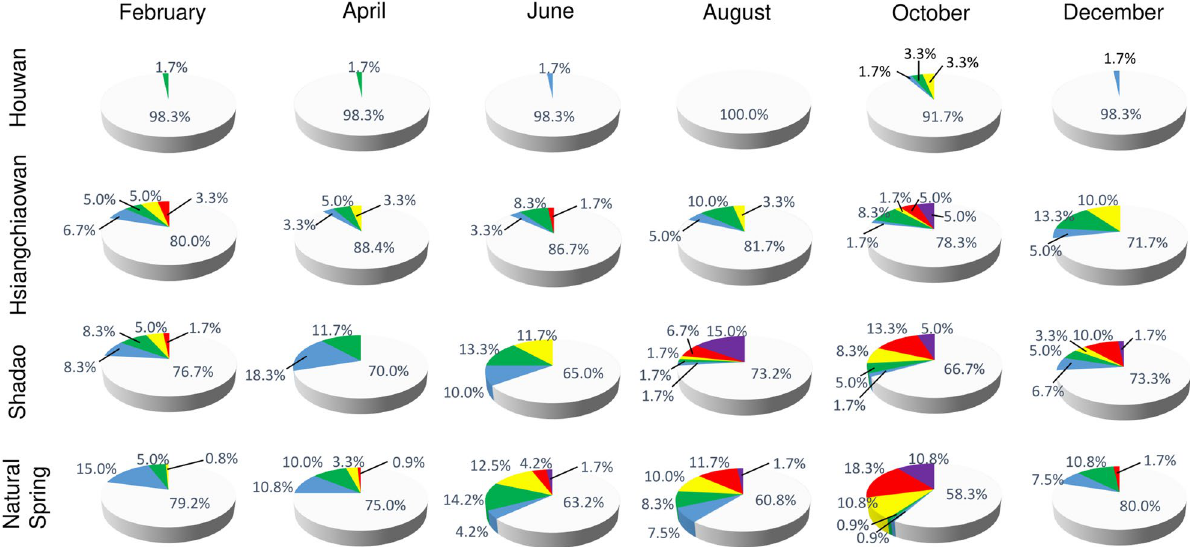
Figure 4. Percentage of sampling points with different worker abundance levels of Anoplolepis gracilipes at the four study sites throughout the study period (grey = abundance score 0; blue = abundance score 1; green = abundance score 2; yellow = abundance score 3; red = abundance score 4; purple = abundance score